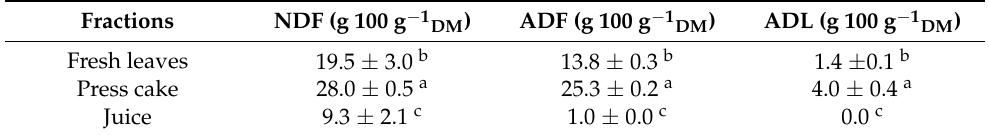
Table 2. Neutral detergent fiber (NDF), acid detergent fiber (ADF), and acid detergent lignin (ADL) of cassava leaf fractions during mechanical